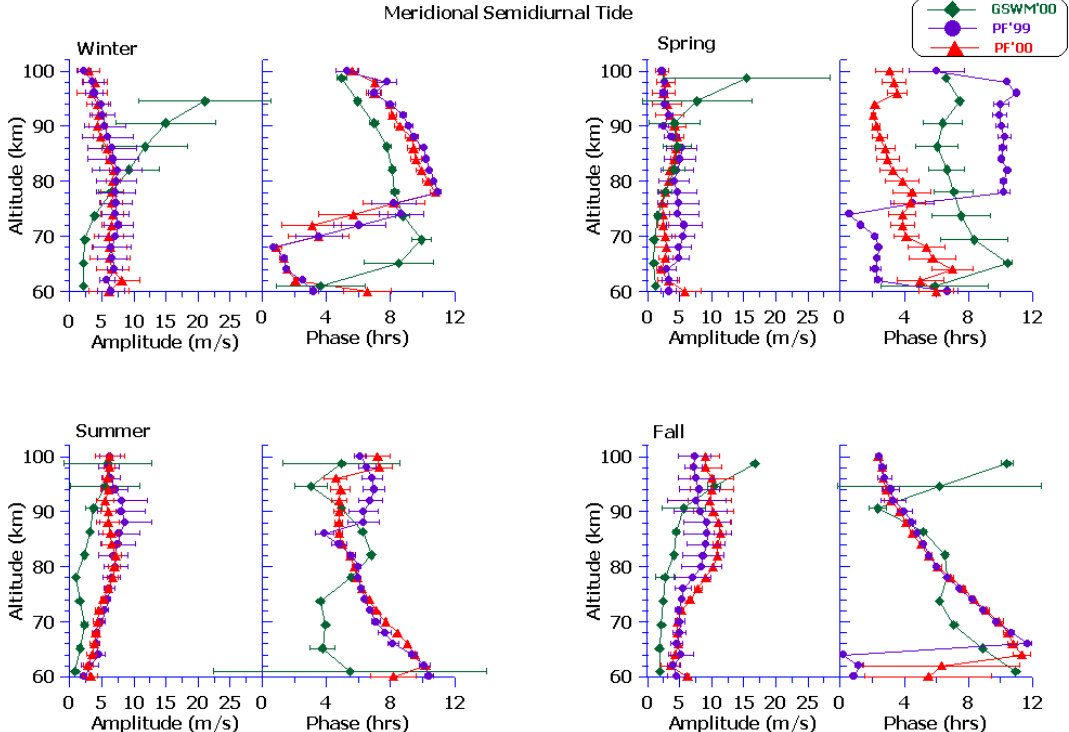
Fig. 7. As in Fig. 6 but for the meridional